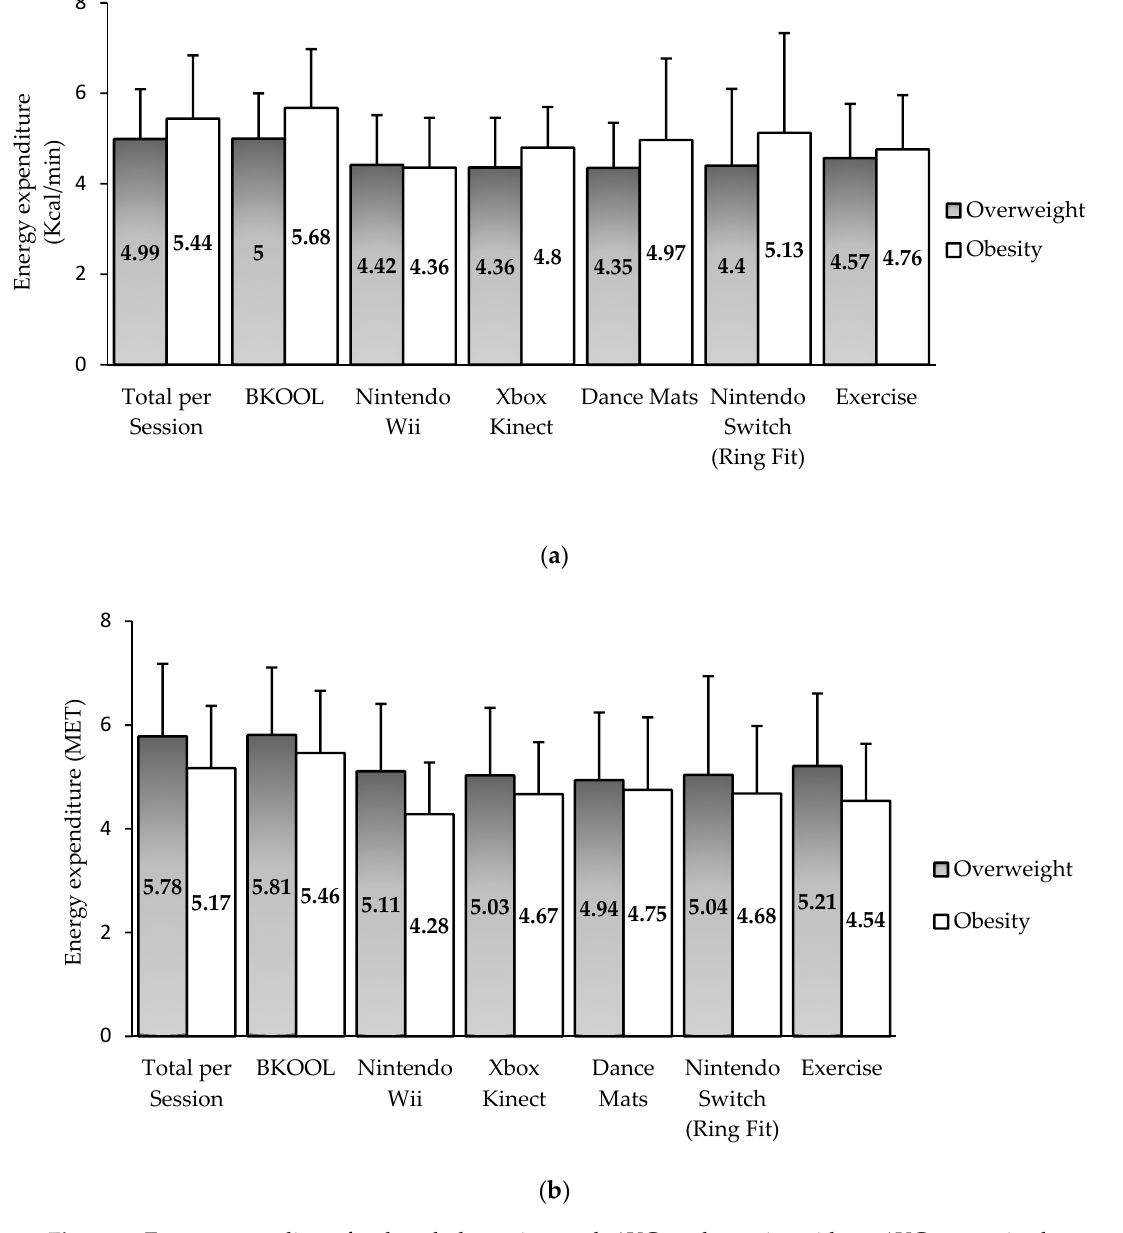
Figure 2. Energy expenditure for the whole session, each AVG, and exercise without AVG categorized by BMI status. ( a ) Energy expenditure measured in kcal/min; ( b ) Energy expenditure measured in MET.